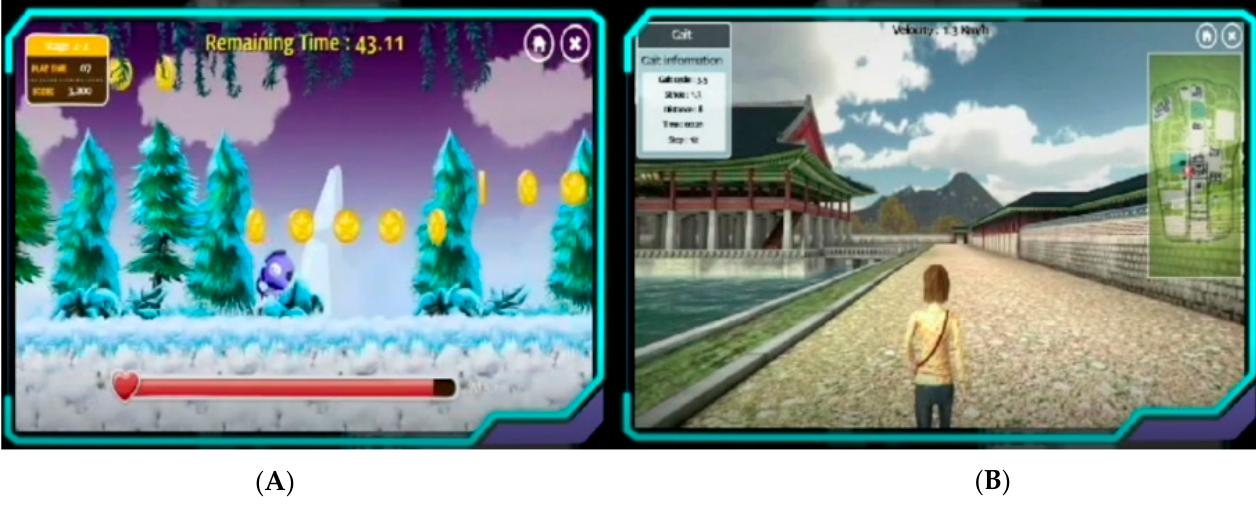
Figure 2. ( A ). Side-scrolling virtual reality game in Walkbot. ( B ). 3D walking-exploring the King’s castle augmented reality in Walkbot.